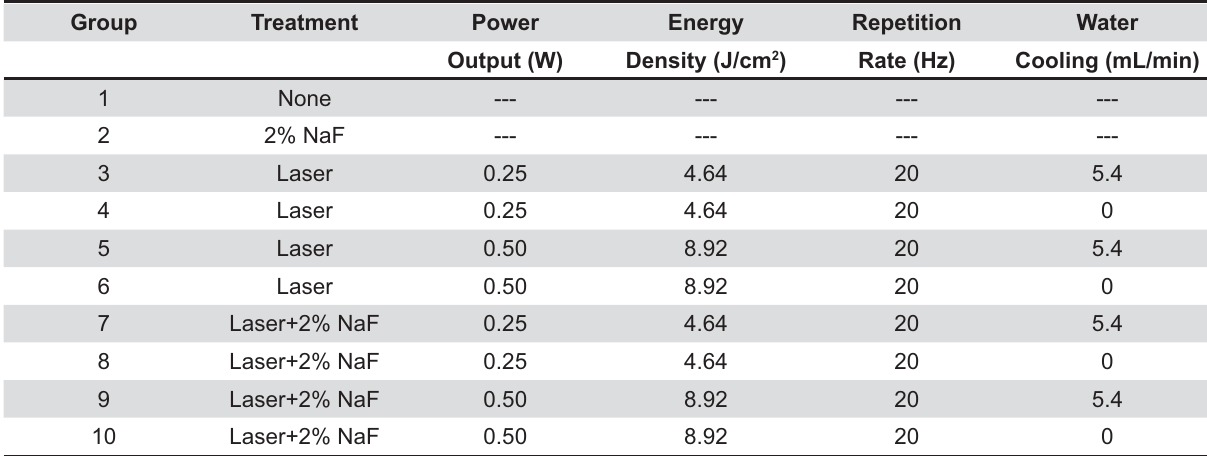
Table 1- Irradiation parameters of the experimental